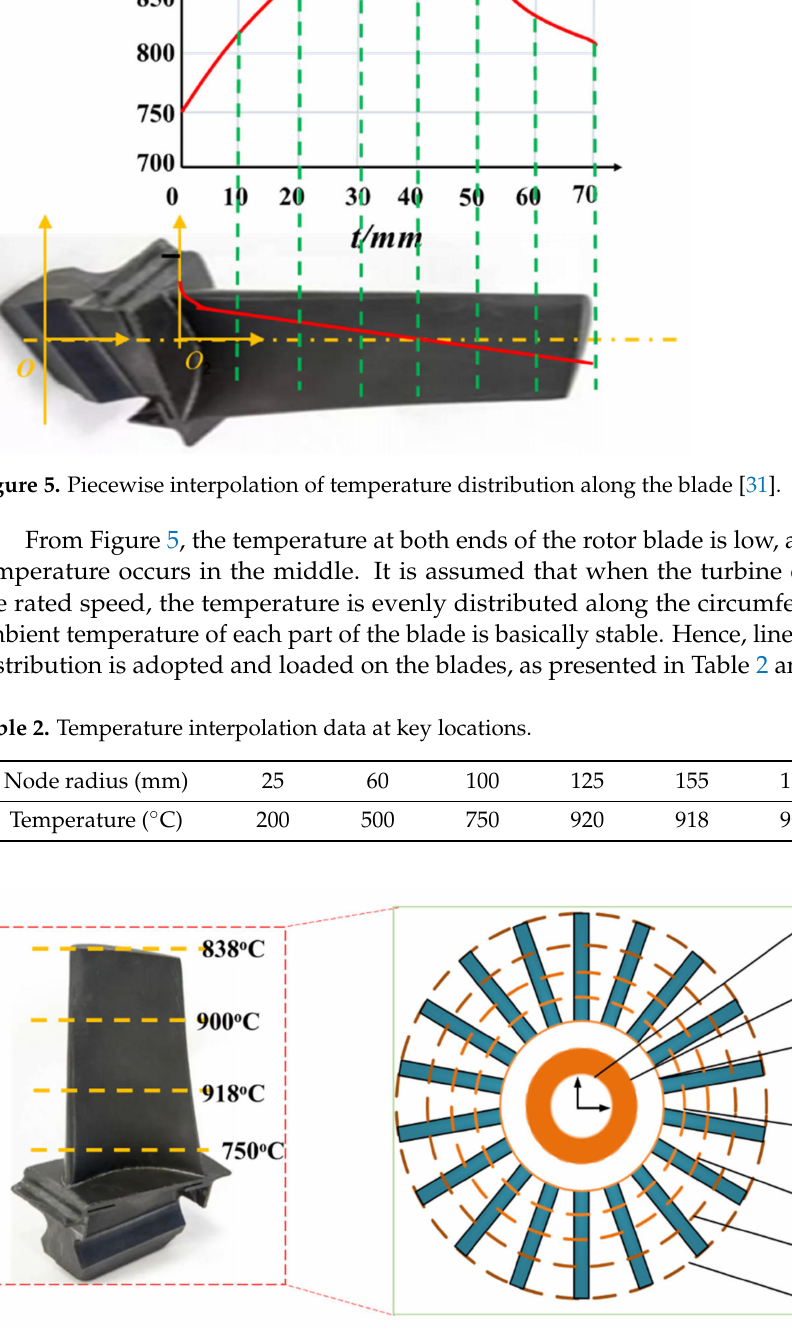
Figure 6. Temperature distribution on the